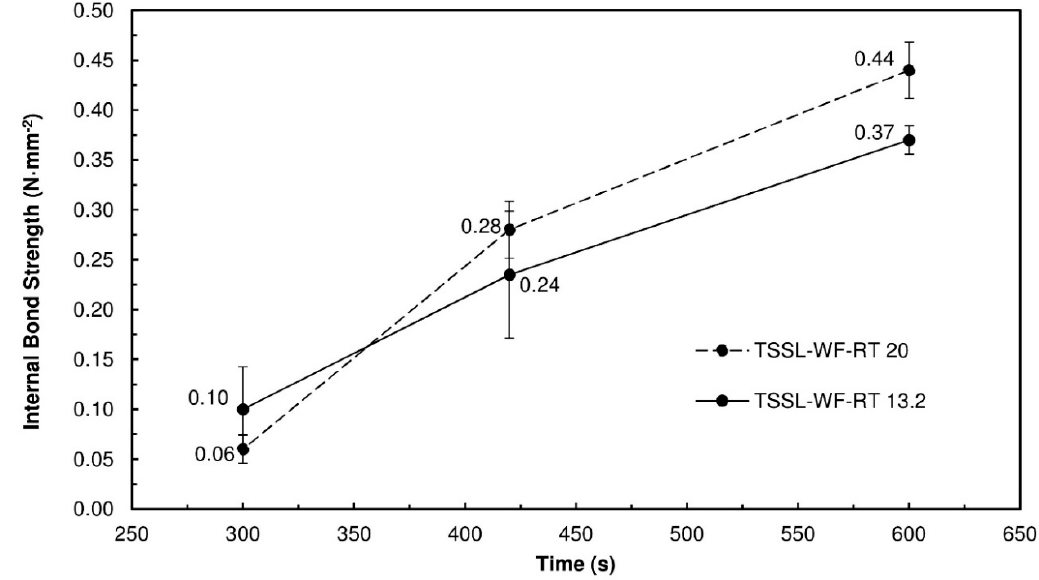
Figure 8. IB strength of PBs produced with the TSSL+WF-RT as a function of different pressing times; the PBs were manufactured with 20% or 13.2% binder solids relative to the dry wood particles and pressed at 190 °C.